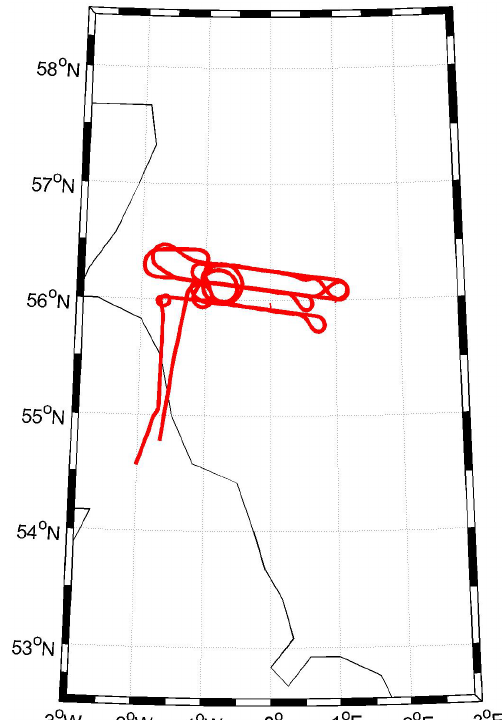
Fig. 1. The aircraft flight track for the B587 flight (19 March 2011, Take off: 14:09:29, Land: 19:22:35), see Sect. 4 for more details, taken from the on-board GPS